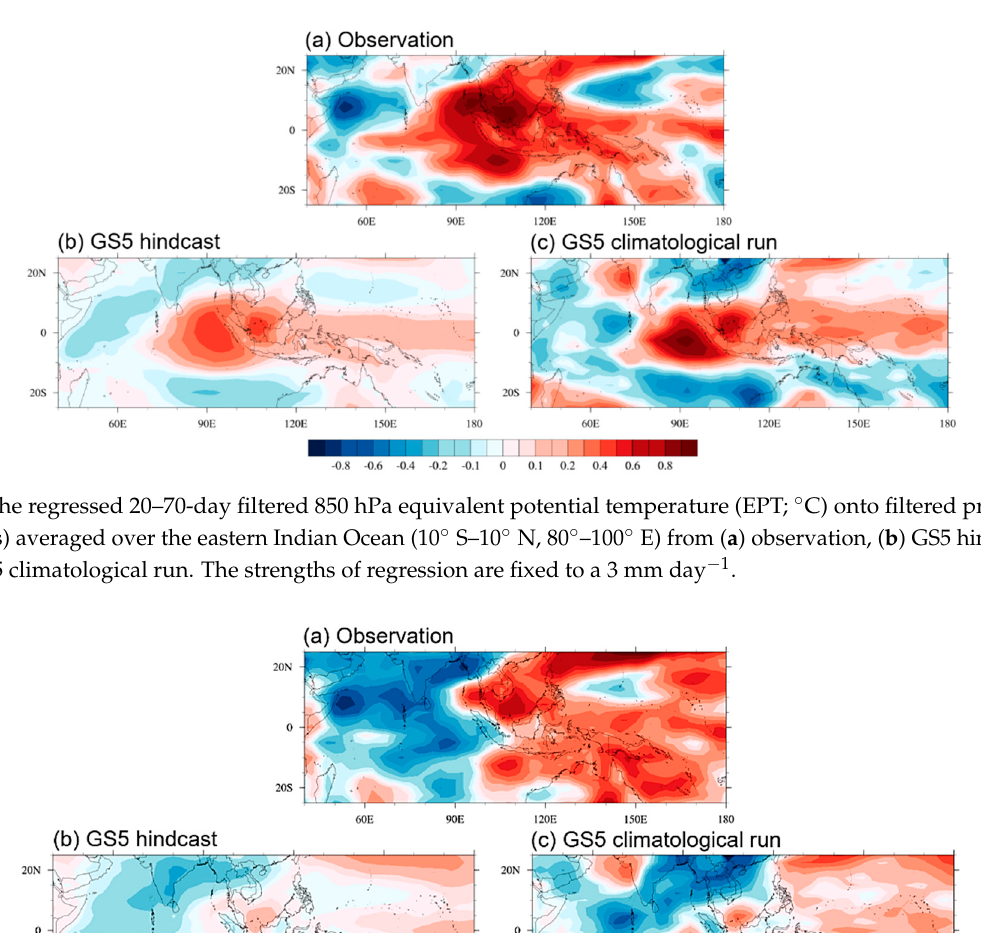
Figure 7. The regressed 20–70-day filtered 850 hPa equivalent potential temperature (EPT; °C) onto filtered precipitation (20–70 days) averaged over the eastern Indian Ocean (10° S–10° N, 80°– 100° E) from ( a ) observation, ( b ) GS5 hindcast data, and ( c ) GS5 climatological run. The strengths of regression are fixed to a 3 mm day − 1 .